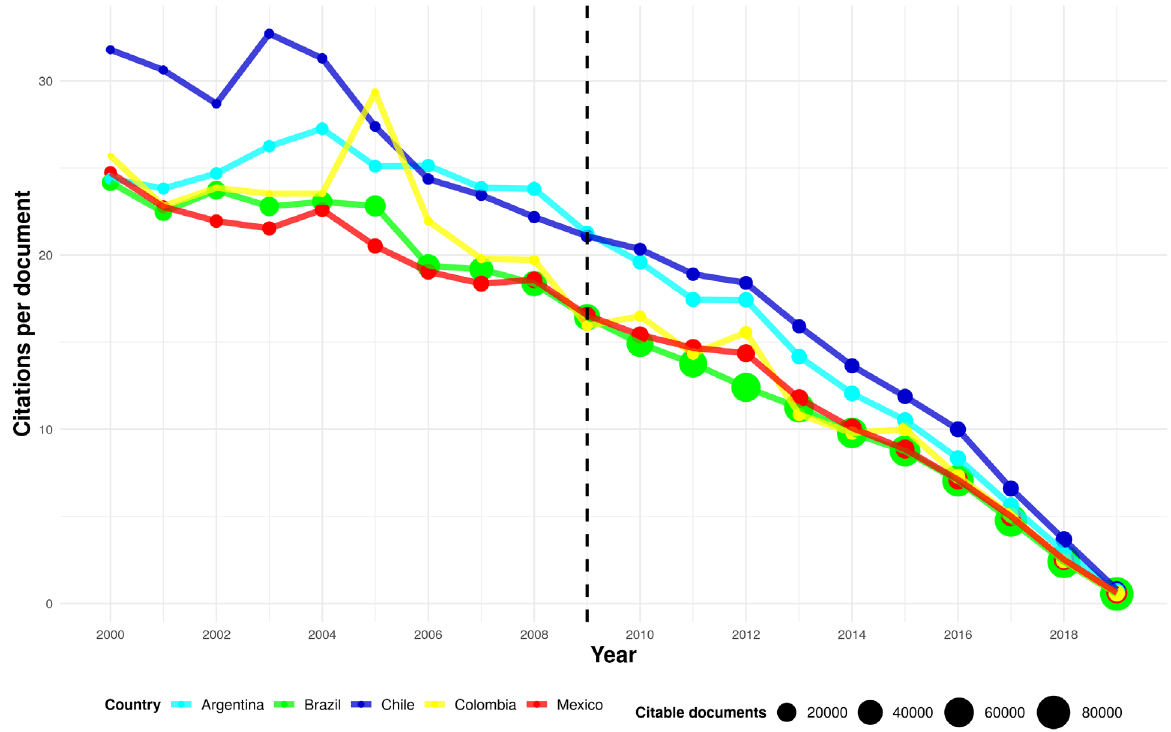
Figure 1. Number of citations per document between 2000 and 2019 in the five Latin American countries publishing more scientific journal articles (according to Scimago’s 2019 country ranking). Countries are identified by colors, while dot size represent the total number of citable documents. The vertical dashed line indicates the year when the new QUALIS system was introduced in